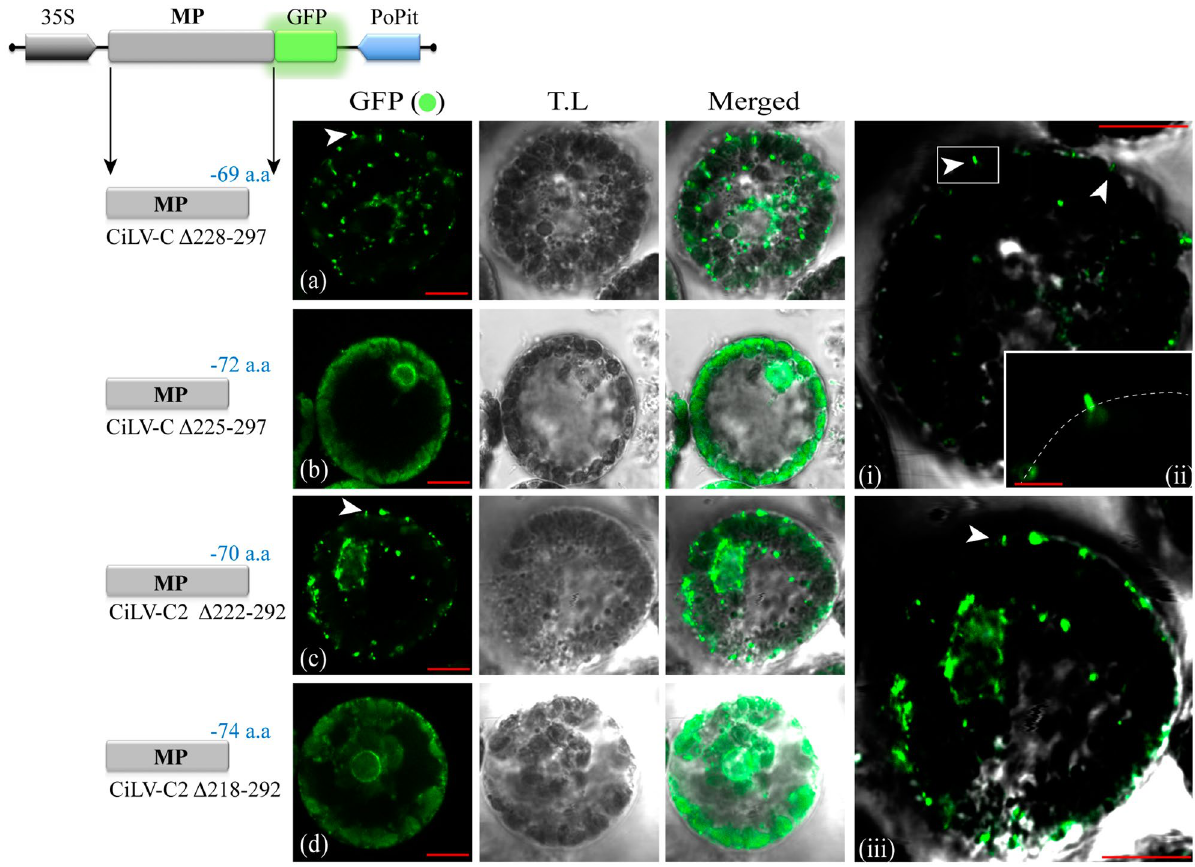
Figure 4. The C-terminal of the cileviruses MP is intrinsically related to the tubule formation. Analysis of tubule formation from transient expression of the truncated MP proteins of the CiLV-C and CiLV-C2 fused at their C-termini with eGFP (green filled circle) on the surface of N. benthamiana protoplasts. Three infiltrated leaves per construct were used for protoplasts isolation. Protoplasts were purified after 1 day post-infiltration and the fluorescence GFP signal was captured 16 h post-protoplasts purification with a Zeiss LSM 780 confocal laser-scanning microscope. Each image-frame expressing GFP represents the visualization of several protoplasts (about 15 to 20) per assay for each MP construct analyzed. The green (GFP), transmitted light (TL) channels and merged images are shown. The scheme indicates the expression cassette introduced into the binary vector pMOG 800 with the 35S cauliflower mosaic virus promotor region (black arrow box), the MP gene (gray box) carrying the eGFP report gene (green box) fused at their C-termini and the potato proteinase inhibitor II terminator region (PoPit) (blue arrow box). The number of deleted residues for each truncated MP is shown in blue. Short tubules are visualized for the MP truncated versions with maximum limit of deletions in movement functions still able to generate cell-to-cell spread (CiLV-C Δ 228–297 and CiLV-C2 Δ 222–292 ), while no tubules were observed for the constructions unable to generate movement (CiLV-C Δ 225–297 and CiLV-C2 Δ 218–292 ). The panels i–iii shown merged images of protoplasts highlighting the presence of short tubules (white arrows). T.L brightness was lowered to facilitate the visualization of short tubules. In panel ii, the dotted line simulates the cell periphery. Red bars correspond to 5–10